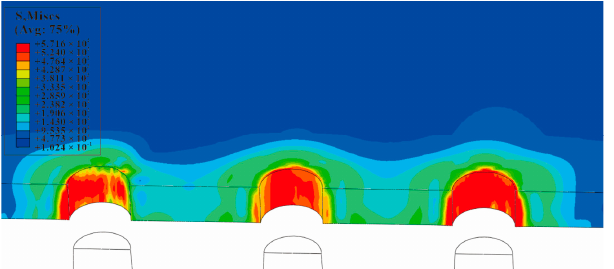
Figure 11. Equivalent von Mises stress at the cross-section of single-hole SSCE: ( a ) equivalent von Mises stress extruded from a single hole without a hidden split sleeve; ( b ) equivalent von Mises stress after extrusion of the single hole with concealed split sleeve (the split sleeve is hidden to show clear stress contours).